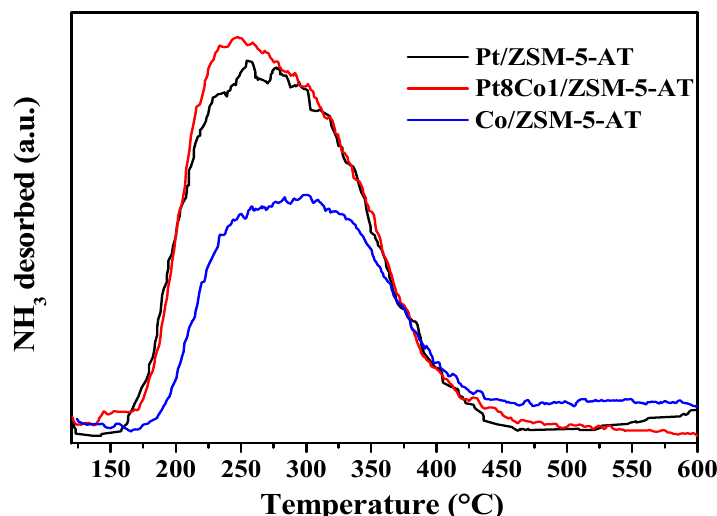
Figure 4. NH 3 -TPD profiles of the as-prepared Pt8Co1/ZSM-5-AT, Pt/ZSM-5-AT and Co/ZSM-5-AT catalysts.